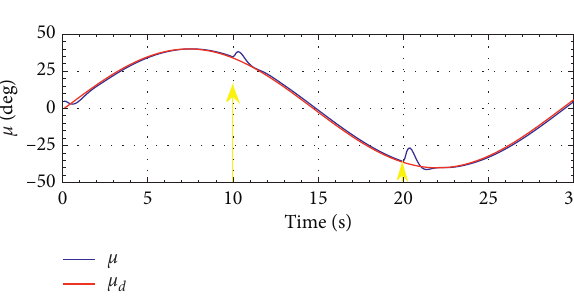
Figure 17: Tracking result of the bank angle μ .